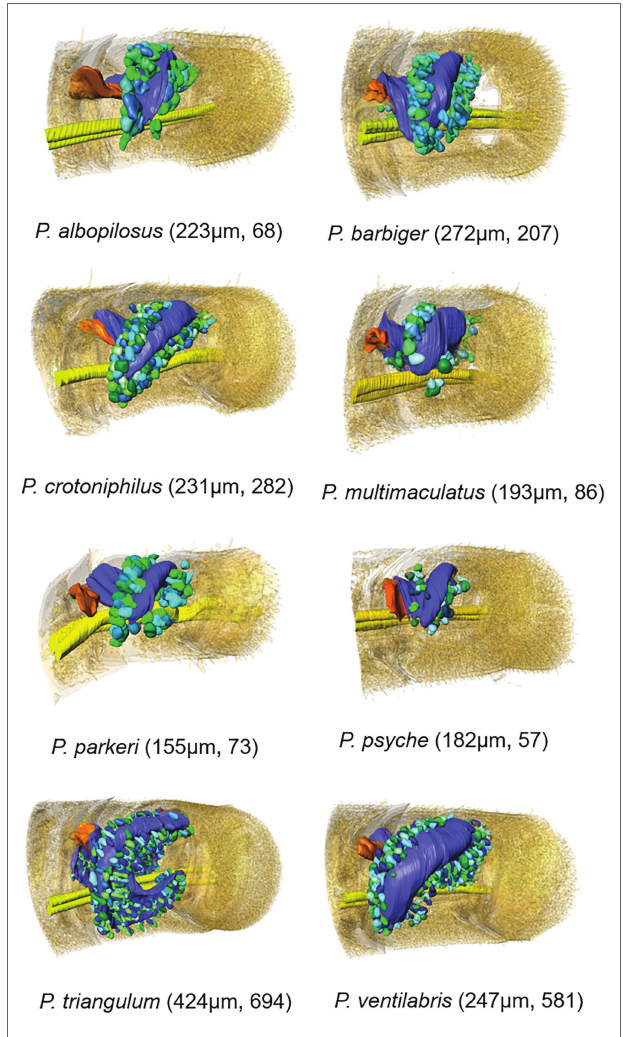
FIGURE 3 | 3D-models based on μ CT data sets of antennal glands in antennomere A6 of females of eight Philanthus species with surrounding gland cell units (length of the respective antennomere and total number of acini in brackets). Color code: different green and turquoise hues: acini; yellow: antennal nerve; orange: flap; and blue: gland reservoir; the outer antennomere cuticle is displayed half